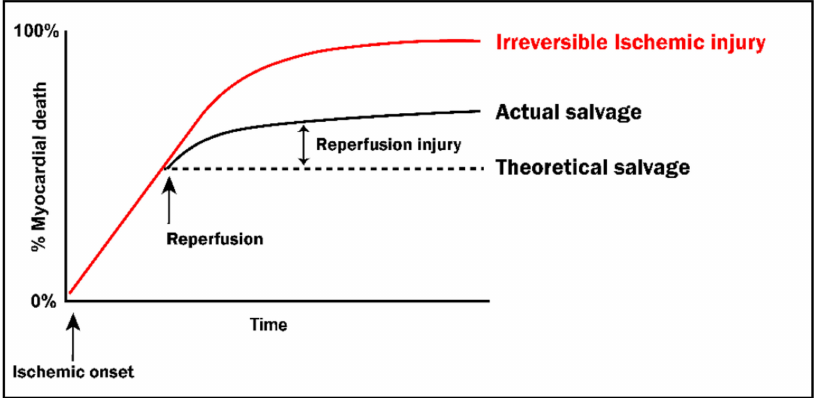
Figure 1. Myocardial ischemia-reperfusion injury. Schematic representation of myocardial cell death as a function of increasing duration of ischemia. In the absence of reperfusion, all cardiomyocytes will die: i.e., ~100% of cells are irreversibly injured (red curve). In theory, timely reintroduction of blood flow would salvage all remaining, previously ischemic cardiomyocytes (dotted line). However, reintroduction of blood flow paradoxically kills (rather than rescues) a population of previously ischemic myocytes—the phenomenon of ‘ lethal ischemia-reperfusion injury ’ (black curve). Adapted from reference